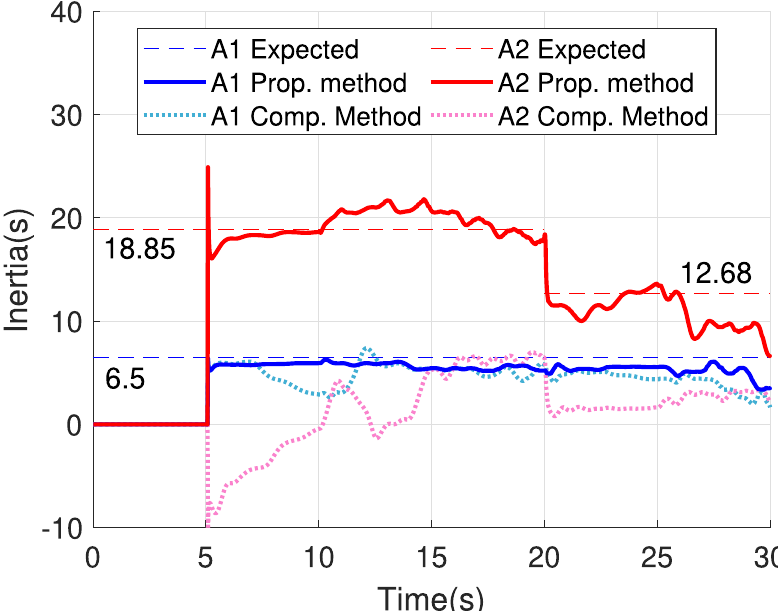
Figure 14. Inertia estimated (inertia variation